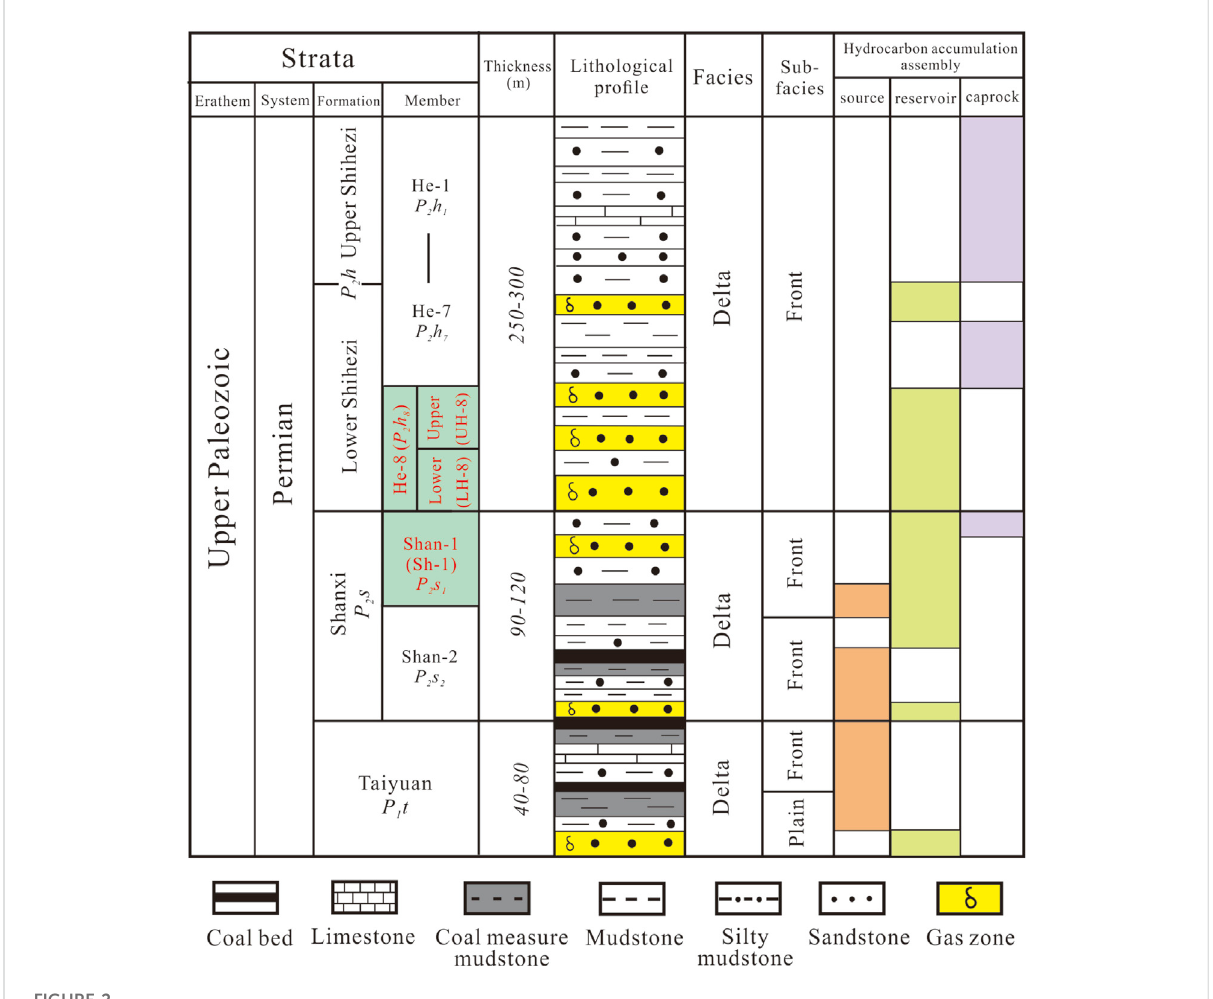
FIGURE 2 Comprehensive stratigraphic column of the study area. The Lower Shihezi Formation ’ s 8th member (He-8, subdivided into “ UH-8 ” and “ LH-8 ” ) and the Shanxi Formation ’ s 1st member (Shan-1, referred to as “ Sh-1 ” ) are highlighted in